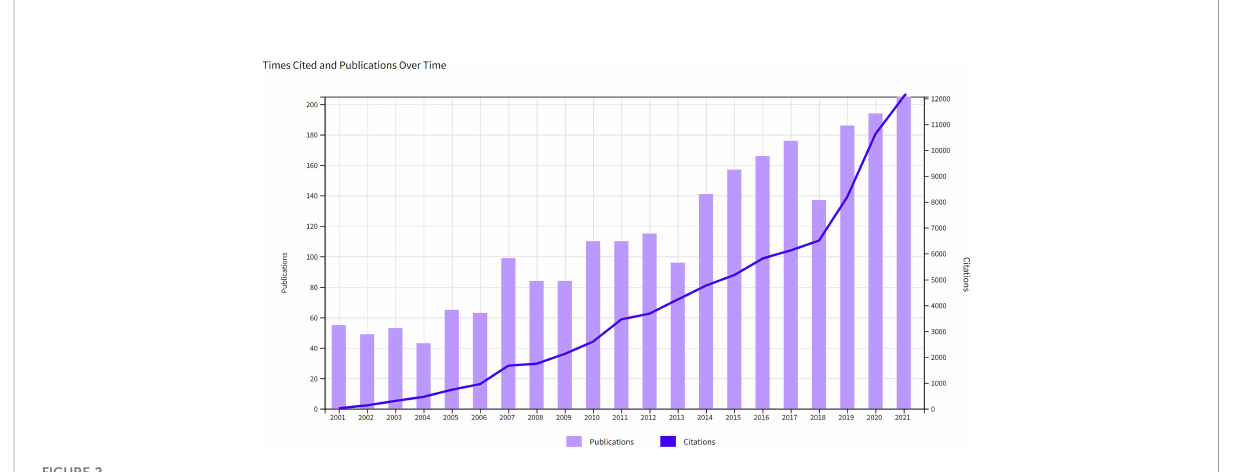
FIGURE 2 Annual publications and citations growth curve from 2001 to 2021.